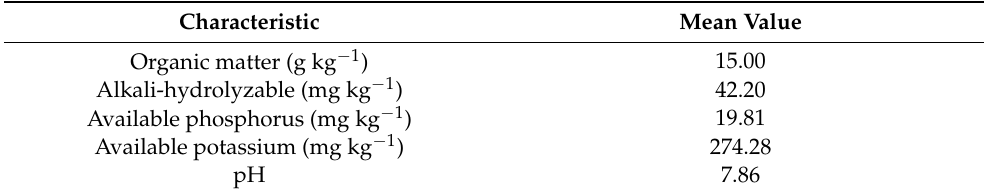
Table 1. The basic physical and chemical characteristics of the 0–20 cm topsoil